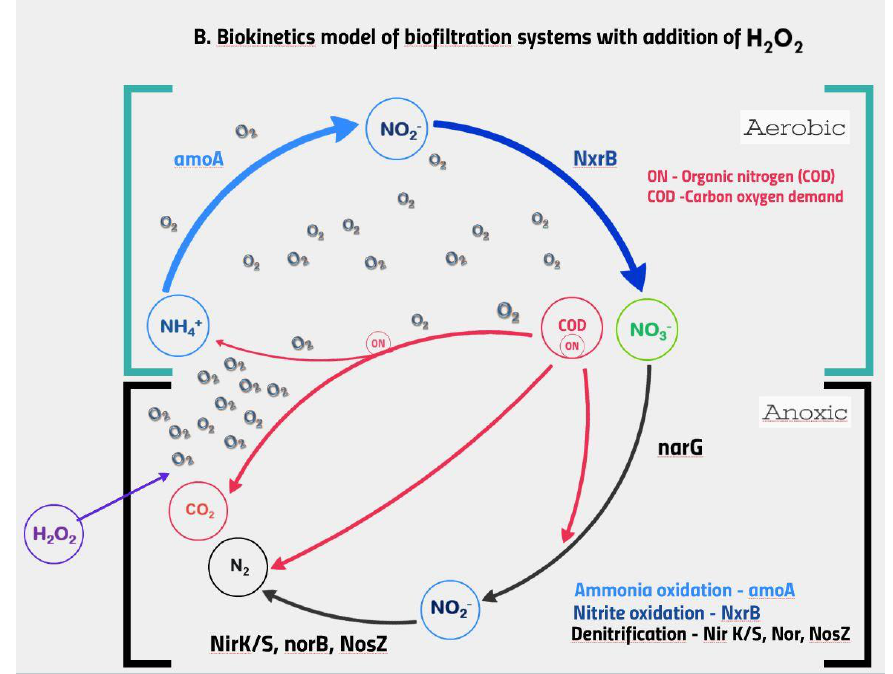
Figure 5. Suggested model for biokinetics of high-rate tertiary systems with the addition of H 2 O 2 . The arrows represent metabolic pathways with the relevant functional groups. Arrow thickness represents reaction rates relatively.